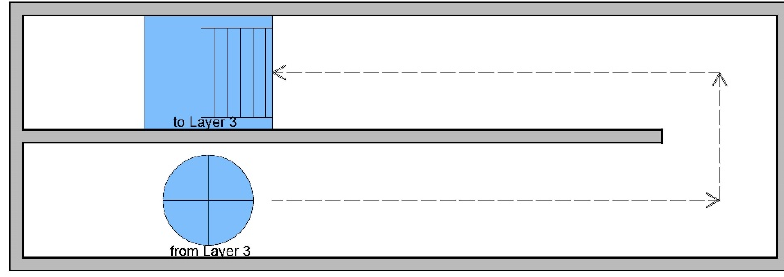
Figure 6. Floor plan for Layer 4.